Question: Express in one sentence what the figure is showing.
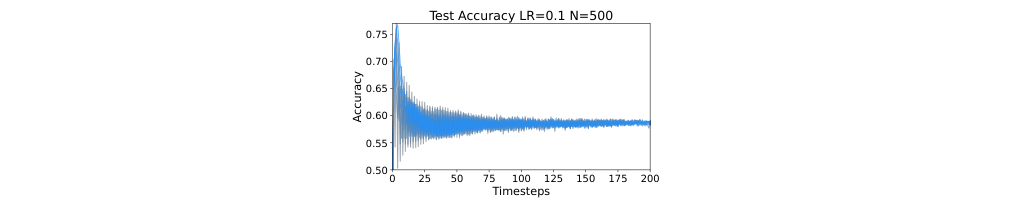
Answer: Behavior with learning rate for linear model/toy Gaussian data with 40% label noise As the learning rate increases, we generally observe a slight improvement in early stopping accuracy in both SGD and SAM.